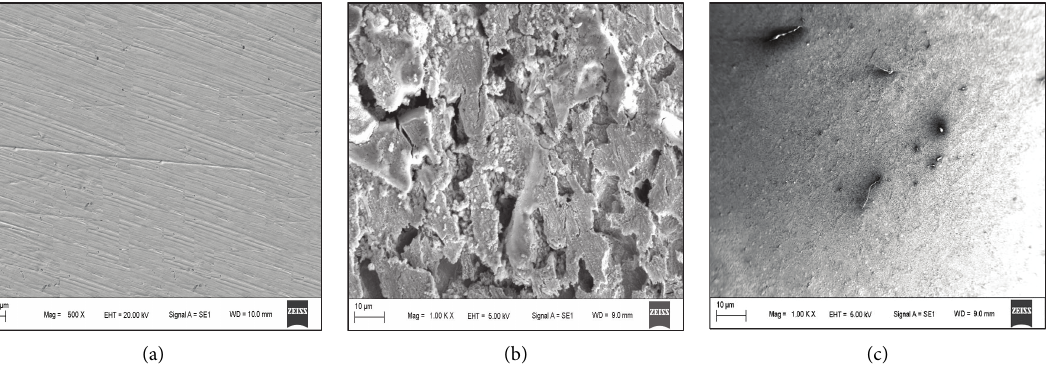
Figure 6: SEM images of original mild steel surface (a) immersed in 1M HCl solution containing different AMP concentrations: 0ppm (b) and 100ppm (c). Table 3: Proton affinity (PA) and gas basicity (GB) values were carried out by using the B3LYP/6-31+G(d, p) method. Compound AMP Protonation site